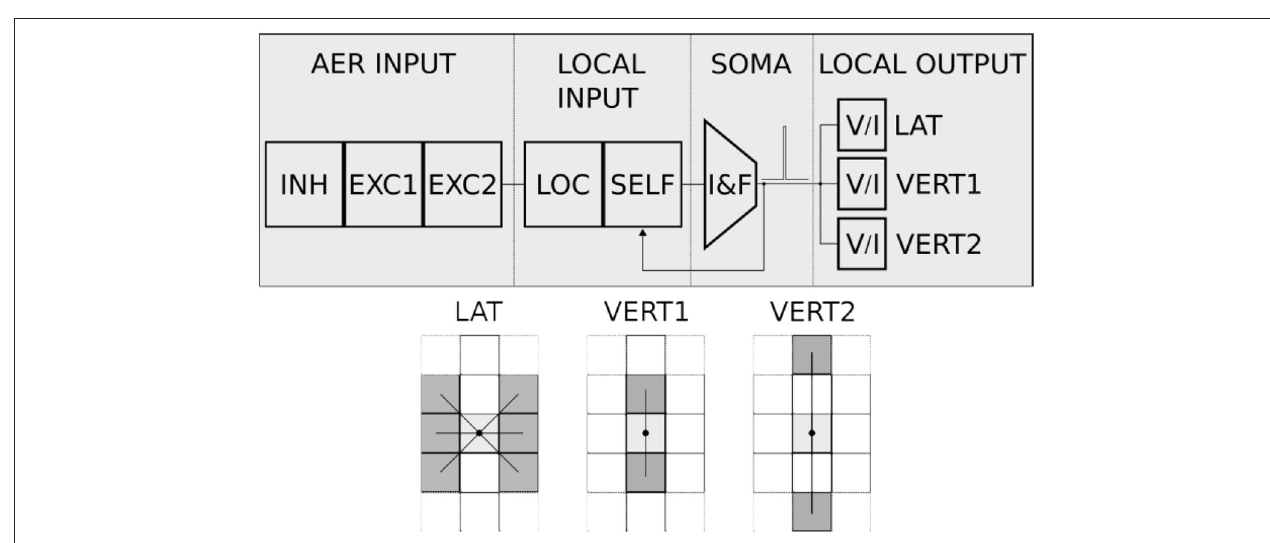
FIGURE 19 | Neuron diagram (top) and local connectivity (bottom). Each neuron comprises the following blocks: AER input, local input, soma and local output. The AER input consists of three AER synaptic circuits: two excitatory and one inhibitory. The local input comprises a diff-pair circuit to integrate all the local excitatory input (see local connectivity diagram below) and an excitatory synapse to implement self-excitation. The soma is an I&F neuron circuit that integrates the sum of all currents generated by the AER input and local input blocks. The local output block generates pulse currents for the local input blocks of the neighbors’ neurons. The pattern of recurrent local connectivity is represented in the bottom diagram. Local cooperation of the 2D network is implemented by activating the lateral (“LAT”) and vertical to first neighbors’ (“VERT1”) local connections. Several 1D networks with first- and second-neighbor cooperation are implemented by activating the vertical to first neighbors’ (“VERT1”) and vertical to second neighbors’ (“VERT2”) recurrent excitatory connections.